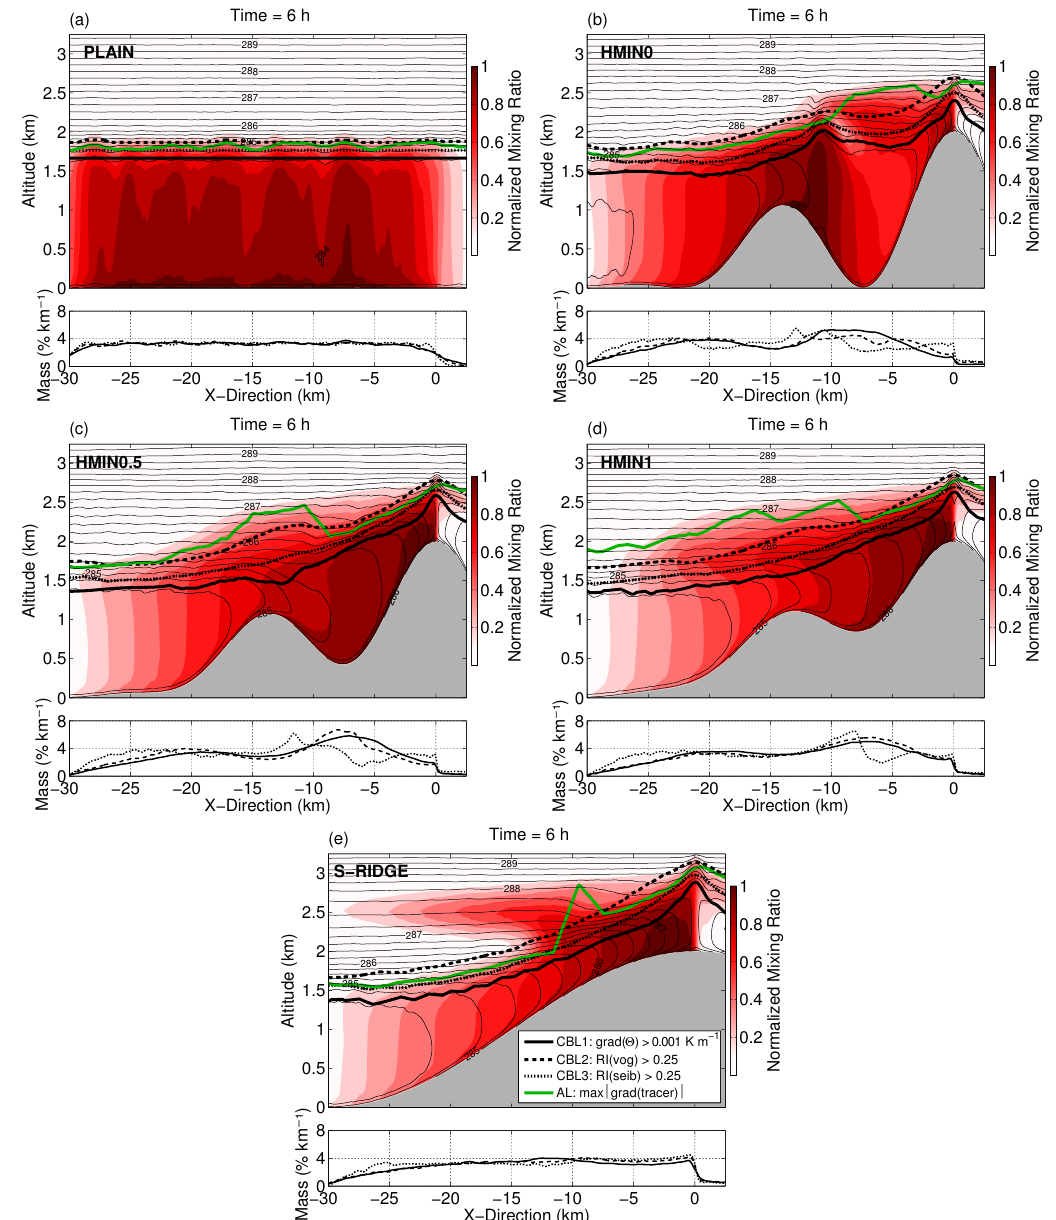
Figure 8. Cross sections of tracer concentrations (color contours) after 6h of simulation for all simulations: (a) PLAIN, (b) HMIN0, (c) HMIN0.5, (d) HMIN1, and (e) S-RIDGE. A passive tracer has been constantly emitted over the whole along-mountain domain within the region of − 30 km ≤ x ≤ 0km on the lowermost eight model levels (up to an altitude of approximately 110m). Mixing ratios are averaged in time and space (along y direction), and normalized by their corresponding maximum value. CBL heights CBL1, CBL2, CBL3, and AL are plotted as black solid, dashed, dotted, and green solid lines, respectively (see also the legend shown in Fig. 8e). Potential temperature is shown as black contour lines (0 . 25K increment). Additionally, vertically integrated tracer masses are shown for 2, 4, and 6h of simulation as dotted, dashed, and solid lines in the bottom panels, respectively. These relative mass values are calculated by splitting the x direction into bins of 1km and determining the percentage of total amount of tracers within these cross-mountain intervals (%km − 1 ).